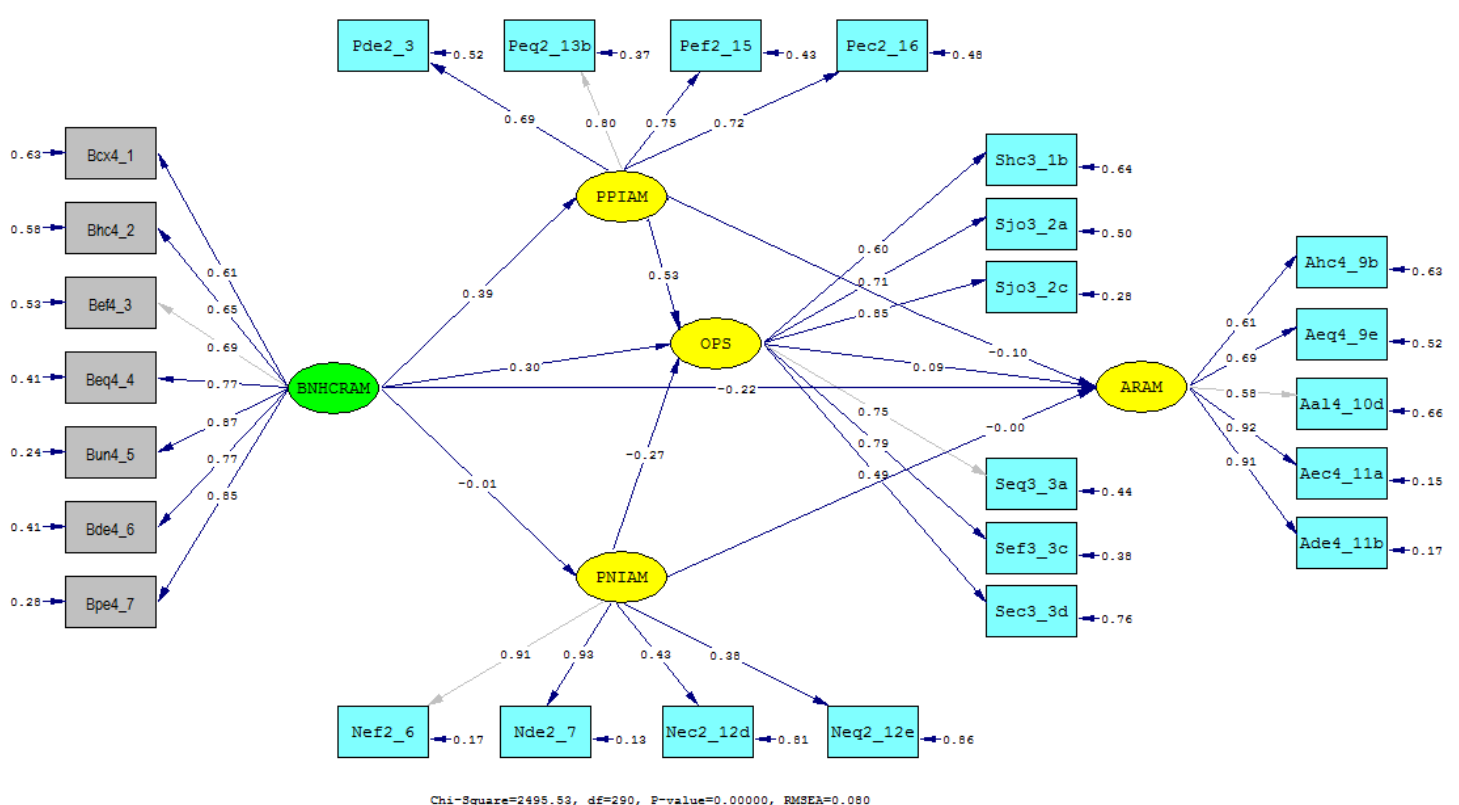
Figure 1. Standardized estimates of the structural equation model. The measurement indicators are in a rectangular shape while the latent constructs are in an oval shape. The arrow from one latent construct to another indicates the direction of the relationship.